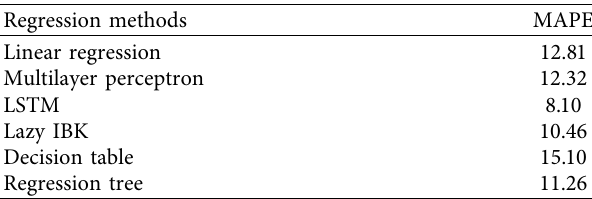
Table 2: Prediction errors of different